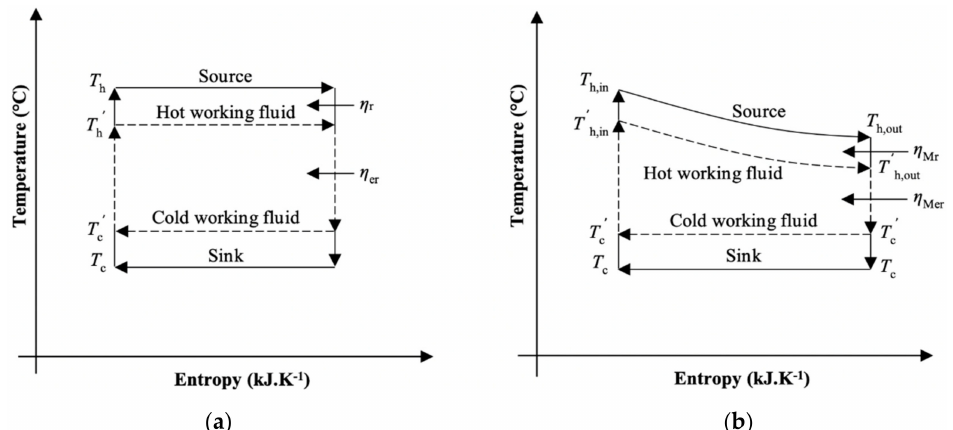
Figure 3. ( a ) Temperature–entropy diagrams of reversible / Carnot (solid) and endoreversible / Novikov (dashed) heat engine cycles as defined by Equations (2)–(4). ( b ) Temperature–entropy diagrams of Mr (solid) and Mer (dashed) heat engine cycles as defined by Equations (5)–(7).